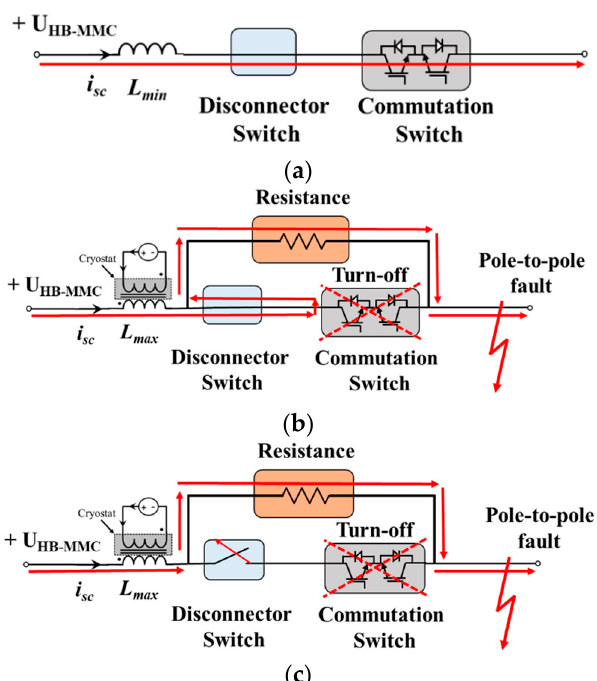
Figure 6. Operation status of the Hybrid-SFCL: ( a ) in normal operation; ( b ) in limiting state I ( t = t 1 ); ( c ) in limiting state II ( t = t 2 = t 1 + ∆ t